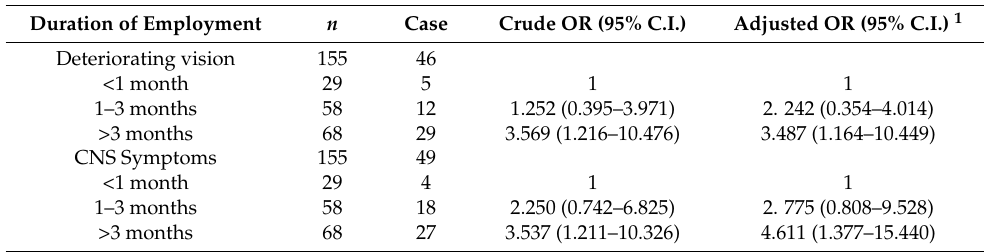
Table 3. Association of employment duration with methanol-exposure-related symptoms: multiple logistic regression